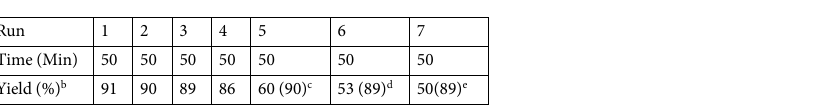
Table 3. Recycling experiments a . a Conditions as mentioned in the text, b,c,d,e The number in bracket specifies the yield of 1,3,4-oxadiazole by using the recycled acidified rGOPhSO 3 H catalyst.